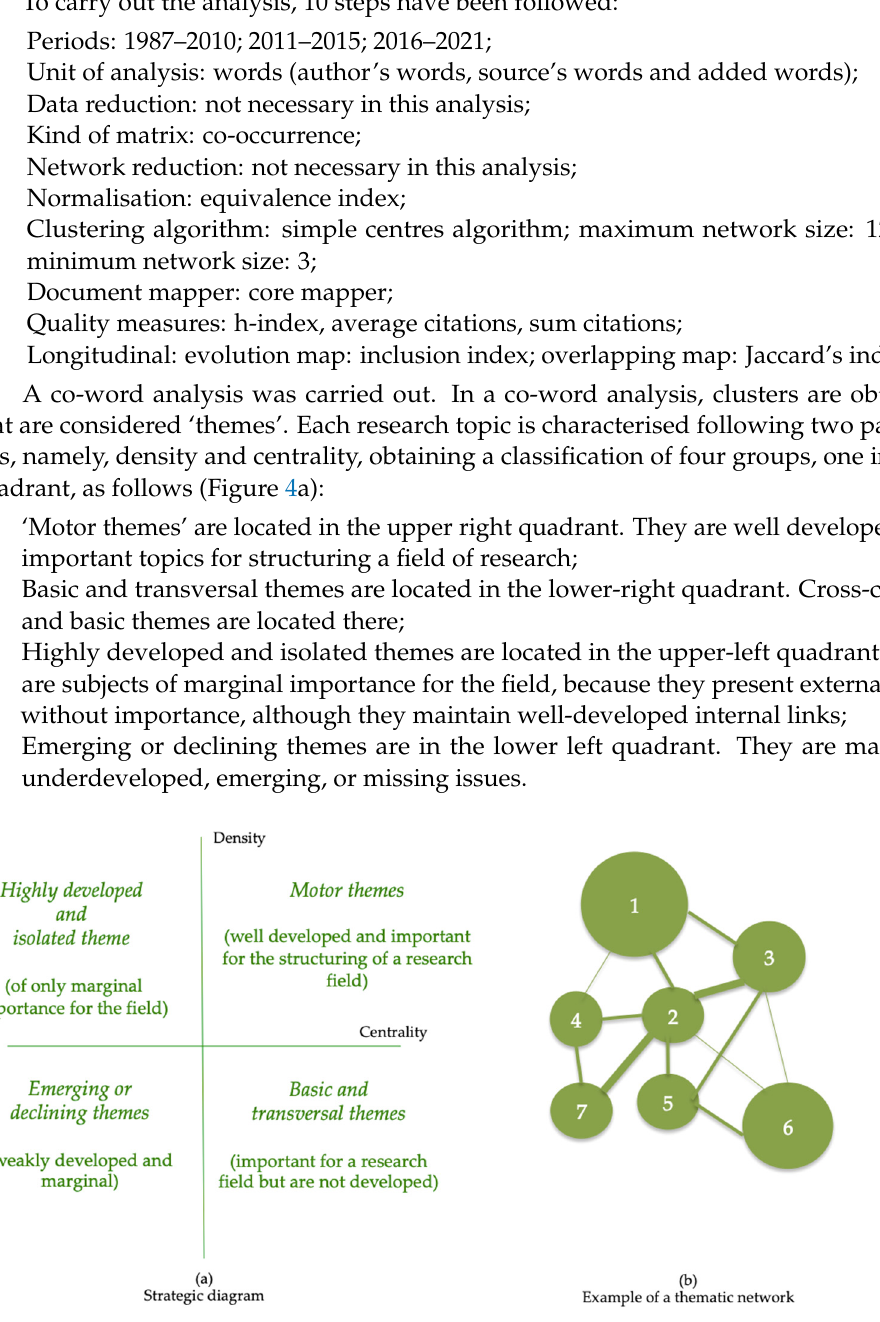
Figure 4. Strategic diagram and thematic network. Source: adapted from Cobo [19]. ( a ) Strategic diagram; ( b ) Example of thematic network .